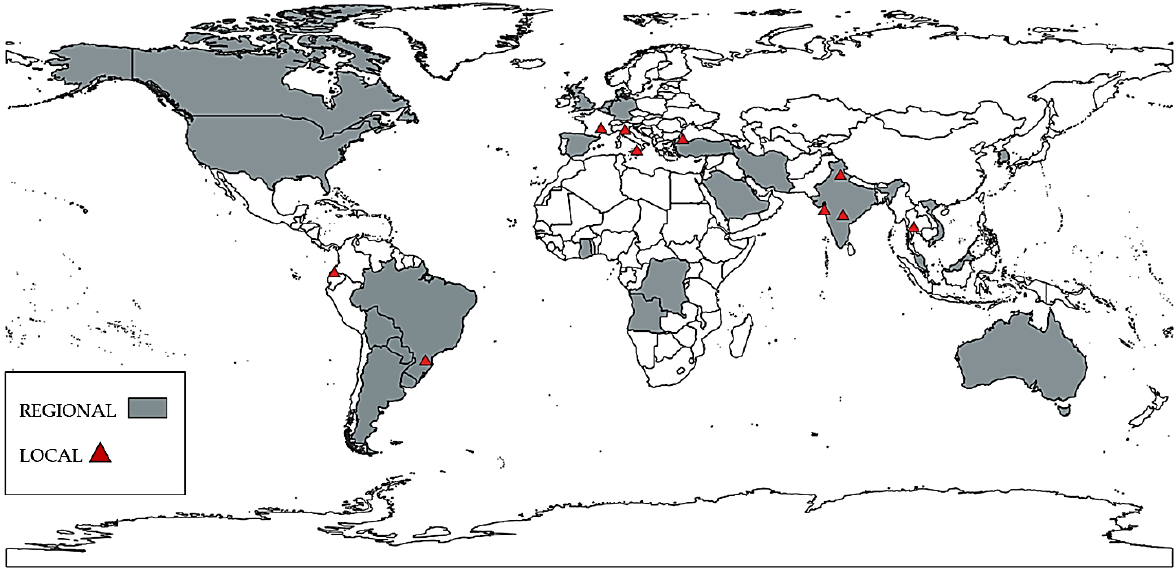
Figure 1. Case studies (regional and local) used to derive IDF curves that are examined in this re-